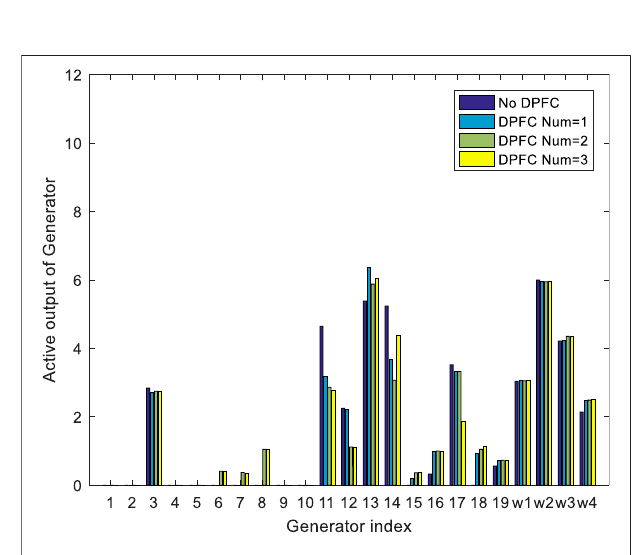
FIGURE 13 | Output of generators w/o